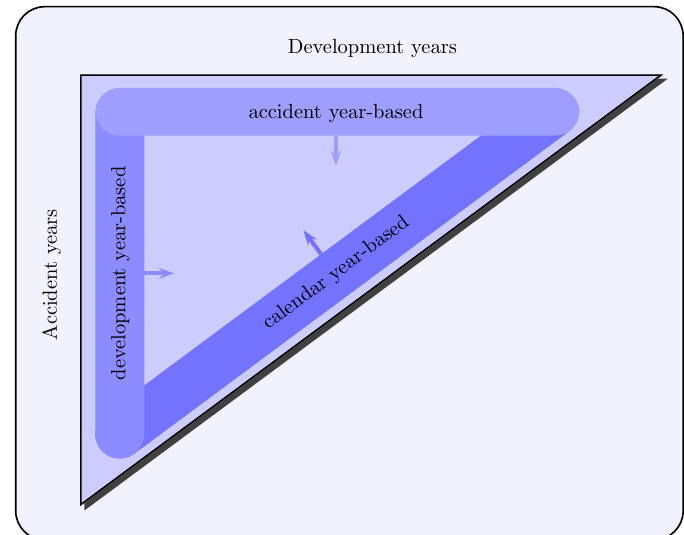
Figure 11. Modeling approaches of the state space representations.